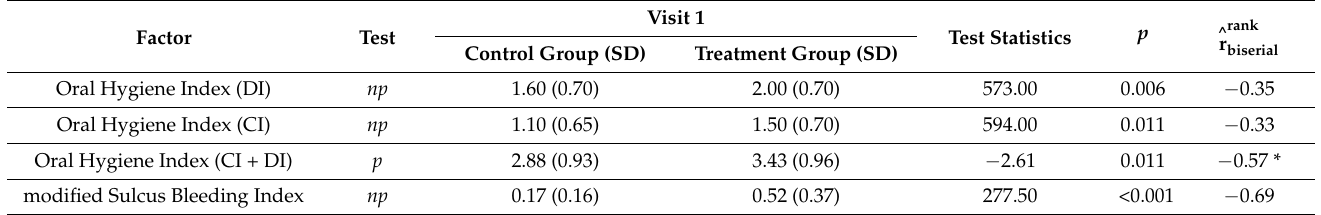
Table 1. Statistically significant results for difference in means between Control and Treatment groups ( n =